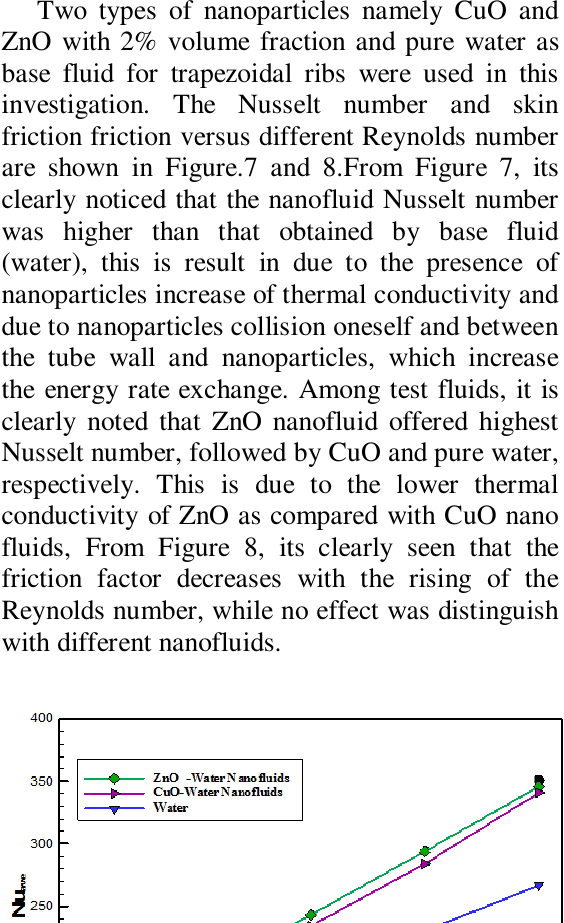
Fig. 6. Variation of skin friction coefficient with trapezoidal at different Reynolds number.